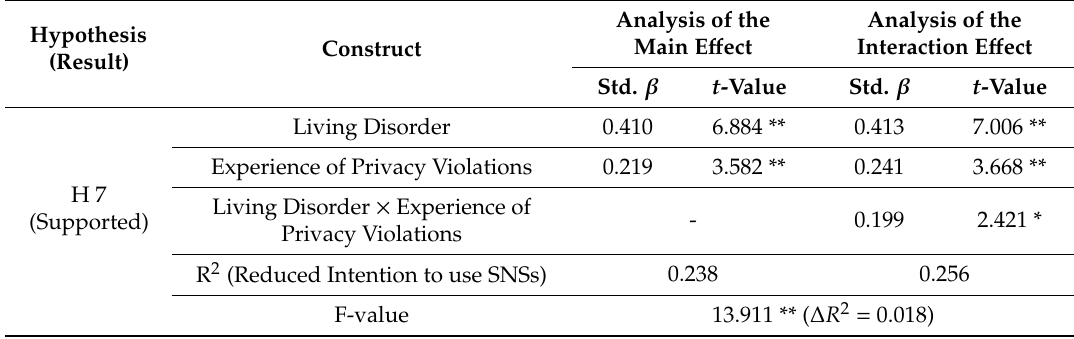
Figure 4. (a) Main effect model; (b) interaction effect model. Figure 4. ( a ) Main e ff ect model; ( b ) interaction e ff ect model. Table 9. Moderating e ff ects Table 8. Moderating effects results.